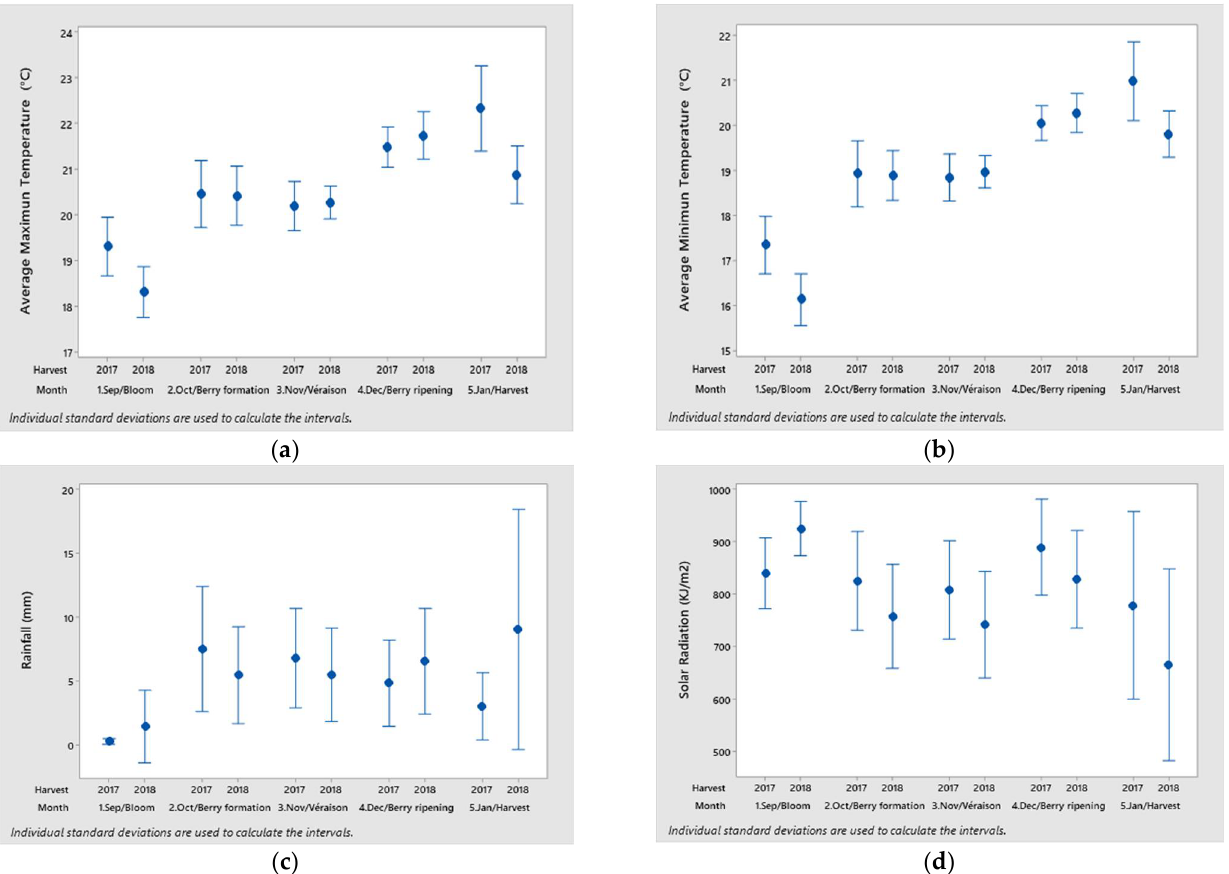
Figure 2. Environment conditions from bloom to harvest from two seasons (2017 and 2018). ( a ) Maximum temperature average (°C). ( b ) Minimum temperature average. ( c ) Rainfall (mm). ( d ) Solar radiation (KJ/m 2 ).